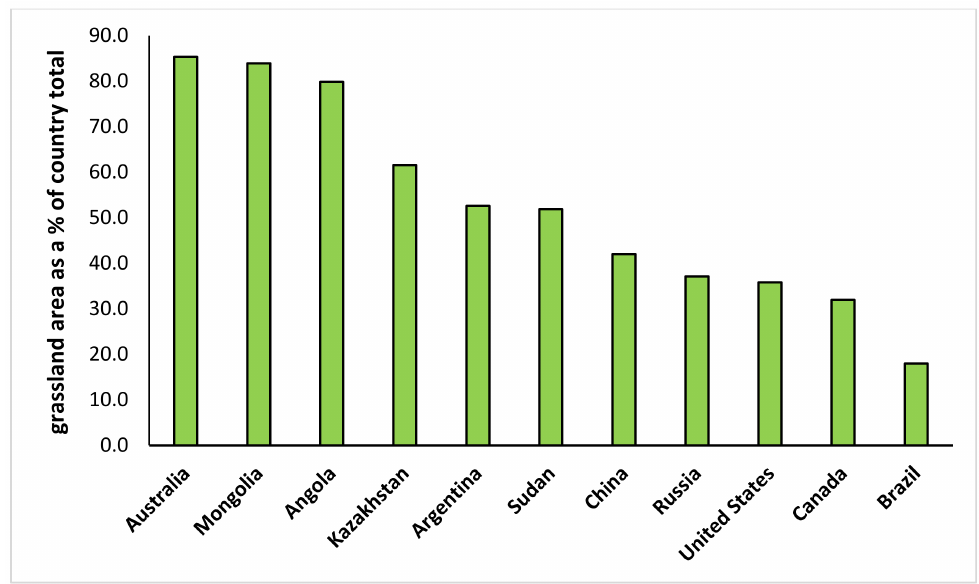
Figure 1. Global top countries for grassland areas (countries with >1 × 10 6 km 2 of grassland) [7]; http://pdf.wri.org/page_grasslands.pdf (accessed on 1 February